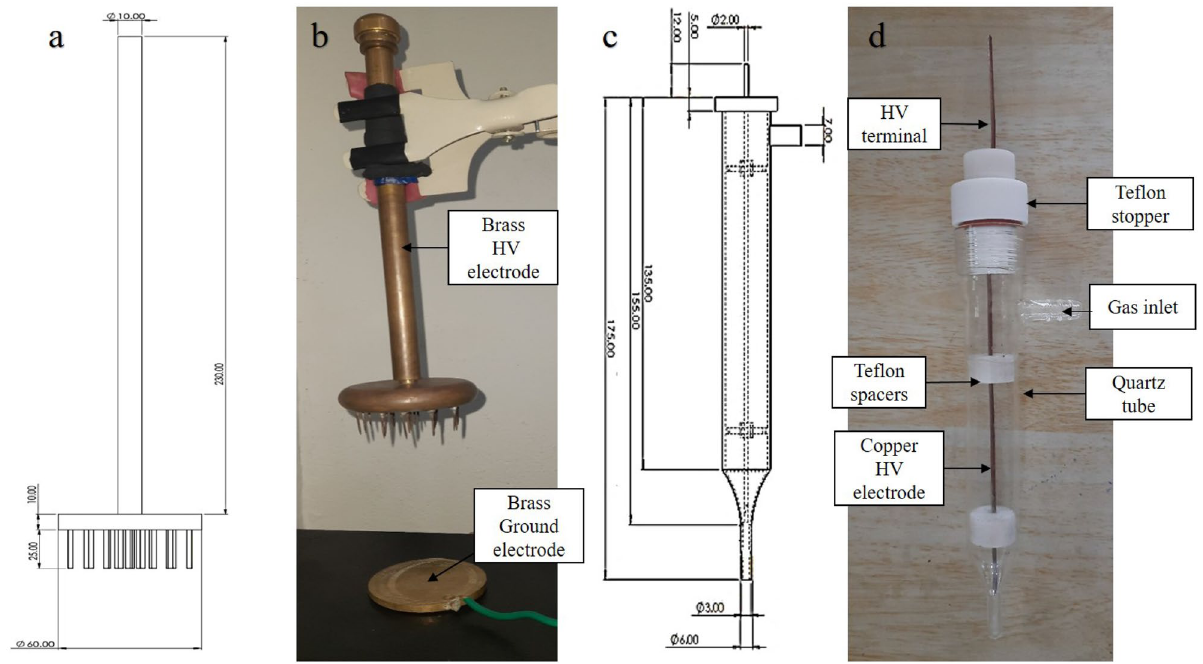
Figure 2. NTP reactor configurations ( a ) schematic cross-sectional diagram of multiple pin electrode with dimensions (in mm); ( b ) photograph of multiple pin electrode; ( c ) schematic cross-sectional diagram of APPJR with dimensions (in mm) and ( d ) photograph of